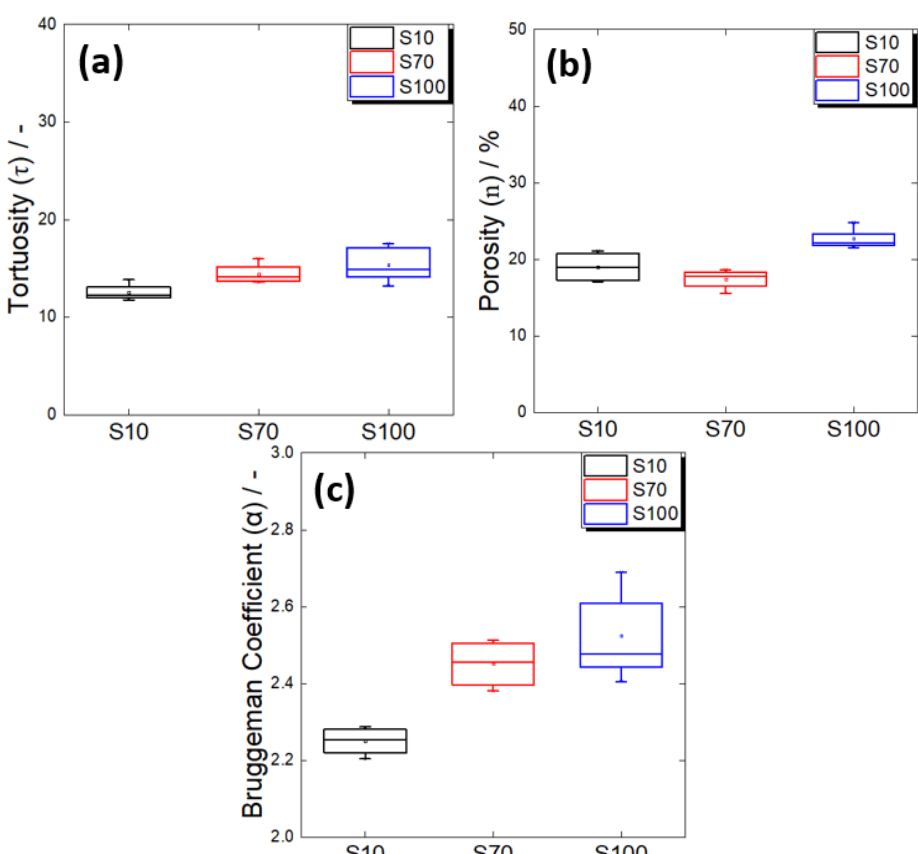
Figure 8. ( a ) Tortuosities, ( b ) porosities, and ( c ) Bruggeman coefficients of the composite electrodes containing spherical Al 2 O 3 powders with different average particle sizes of 10 µ m (S10), 70 µ m (S70), and 100 m (S100).